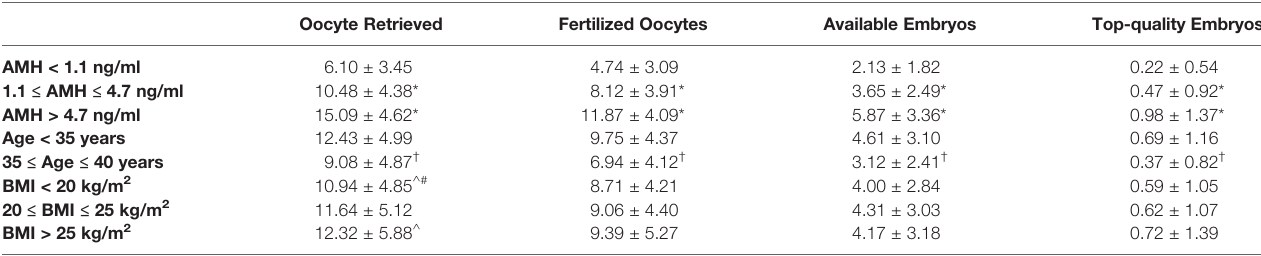
TABLE 3 | Poisson regression analysis of factors associated with the embryological outcomes. Oocyte Retrieved Fertilized Oocytes Available Embryos Top-quality